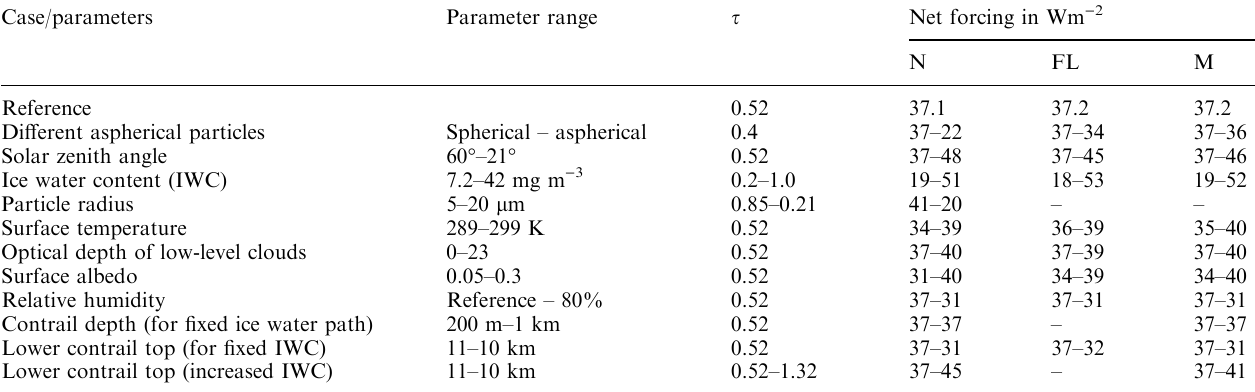
Table 6. Sensitivity of the daily mean net TOA flux change by contrails to various parameters for 100% contrail with given optical depth s at 0 : 55 l m. Results from models N, FL, and M, where available Case/parameters Parameter range